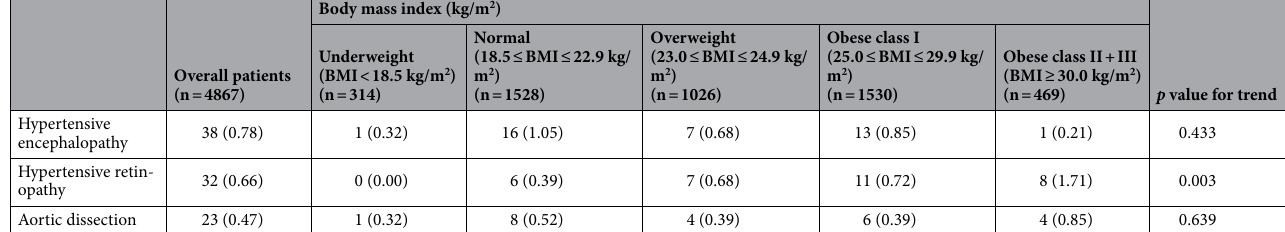
Table 1. Baseline characteristics. Values for continuous variables are presented as means (SD), and categorical variables are presented as numbers (percentage). BMI, body mass index; SD, standard deviation; SBP, systolic blood pressure; DBP, diastolic blood pressure; eGFR, estimated glomerular filtration rate; BNP, B-type natriuretic peptide; CT, computed tomography; HMOD, hypertension-mediated organ damage. a Coronary artery disease was defined as a composite history of coronary artery disease, percutaneous coronary intervention, or coronary artery bypass graft surgery. b Proteinuria was defined as a dipstick urinalysis result ≥ 1 +.